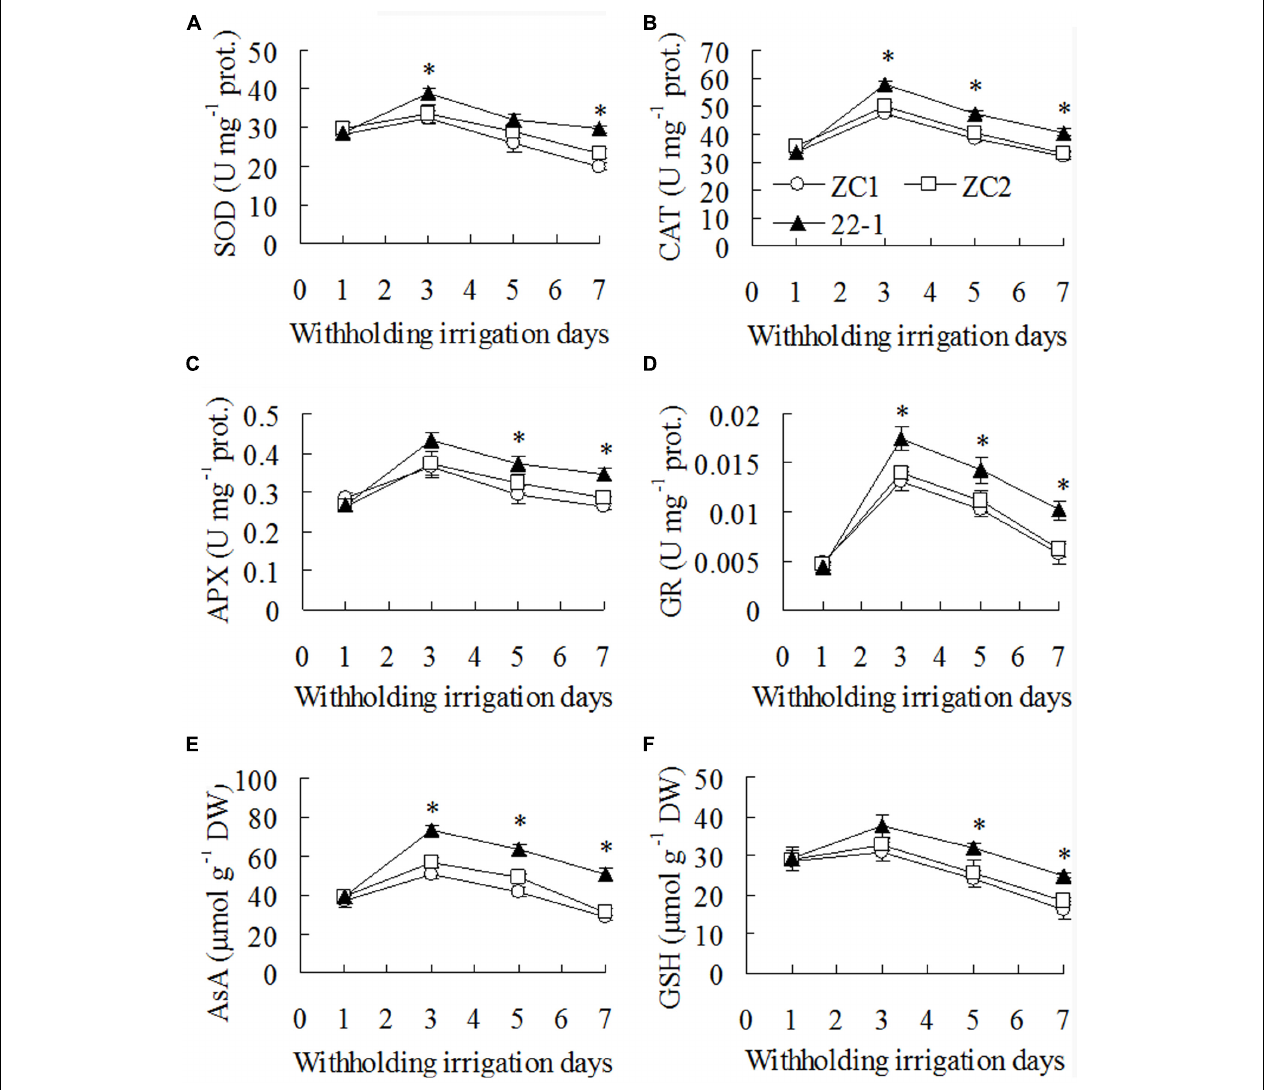
FIGURE 3 | Superoxide dismutase (SOD, A) , ascorbate-peroxidase (APX, B ), catalase (CAT, C ) and glutathione (GSH) reductase (GR, D ) activities and ascorbic acid (AsA, E ) and reduced GSH (F) contents in the mutant 22-1 in comparison with two wild type plant lines (ZC1, ZC2) in response to drought stress. Means of three independent plant samples and the standard errors are presented; an asterisk indicates significant difference between 22-1 and the wild types at P < 0.05 at a given time.